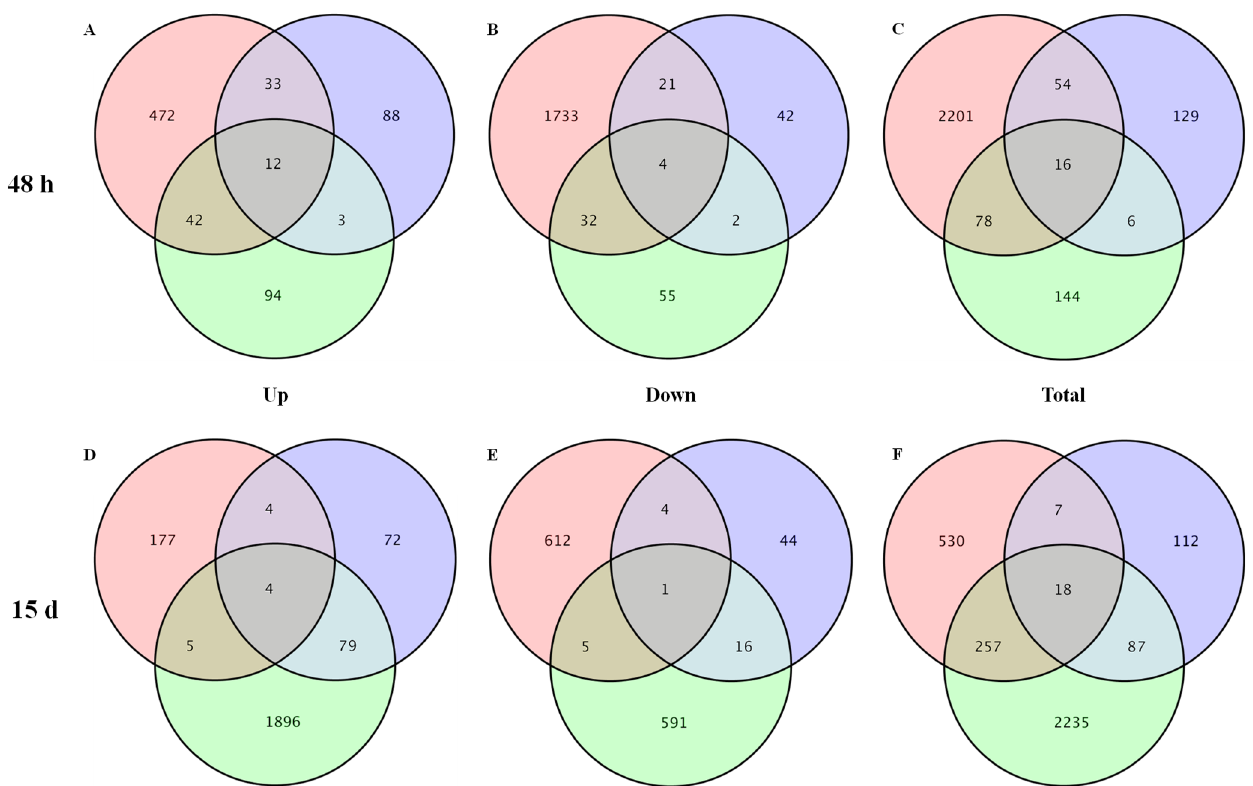
Figure 2. A Venn diagram describing overlaps among differentially expressed genes (DEGs) in XZ153, XZ141, and ZD9. ( A ) Up-regulated genes at 48 h after low-K treatment. ( B ) Down-regulated genes at 48 h after low-K treatment. ( C ) Total-regulated genes at 48 h after low-K treatment. ( D ) Up-regulated genes at 15 d after low-K treatment. ( E ) Down-regulated genes at 15 d after low-K treatment. ( F ) Total-regulated genes at 15 d after low-K treatment. Pink, purple, and green represents genotype XZ153, XZ141, and ZD9, respectively.